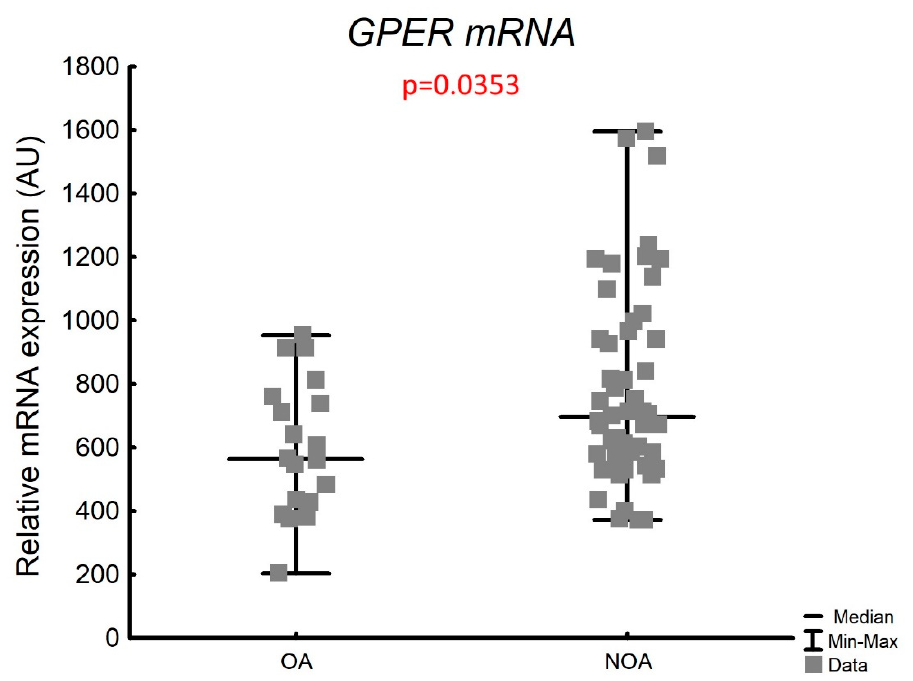
Figure 2. GPER transcriptional level in the whole testicular tissue in studied group. AU—arbitrary units (relative quantification normalized to the reference gene RPS29 using the ∆ Ct method); OA— obstructive azoospermia with complete spermatogenesis; NOA—non-obstructive azoospermia with impaired spermatogenesis. p value—Mann–Whitney